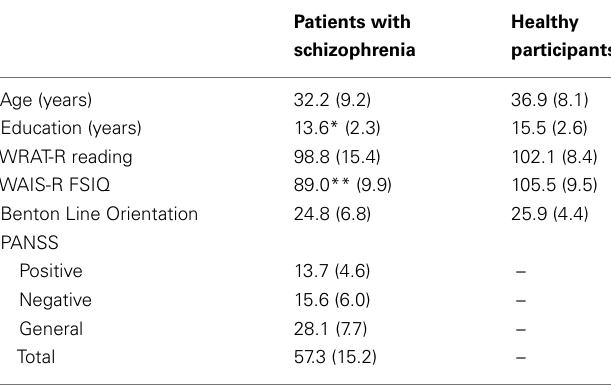
Table 1 |Age, education, IQ, reading scores, and symptom ratings in patients with schizophrenia and healthy